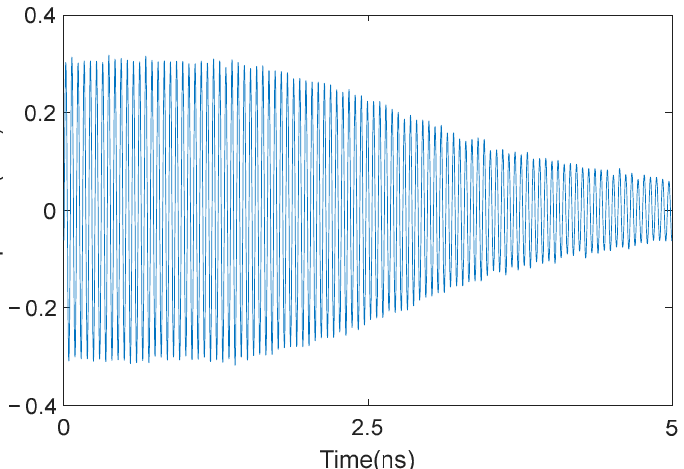
Figure 5. Experimental results of the modulation function with a maximum spectral width of 0.5 nm.